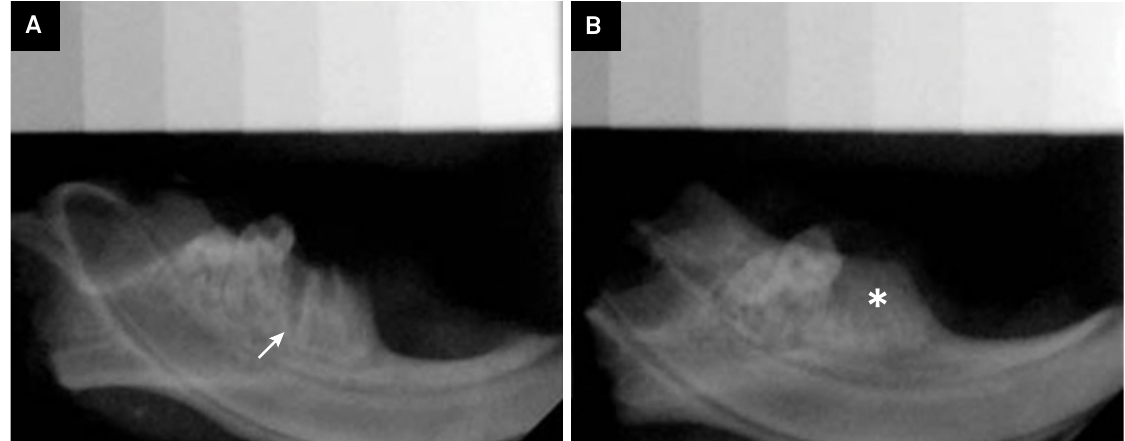
Figure 6. Radiographic features of the alveolar socket healing after 28 days of tooth extraction in animals treated with ALN (A) and sterile physiological saline (B). In the AL group (a), the linings of the alveolar socket (arrow) are more evident compared with those of the control animals (asterisk) and also presented sclerosis on the M1 alveolar lamina